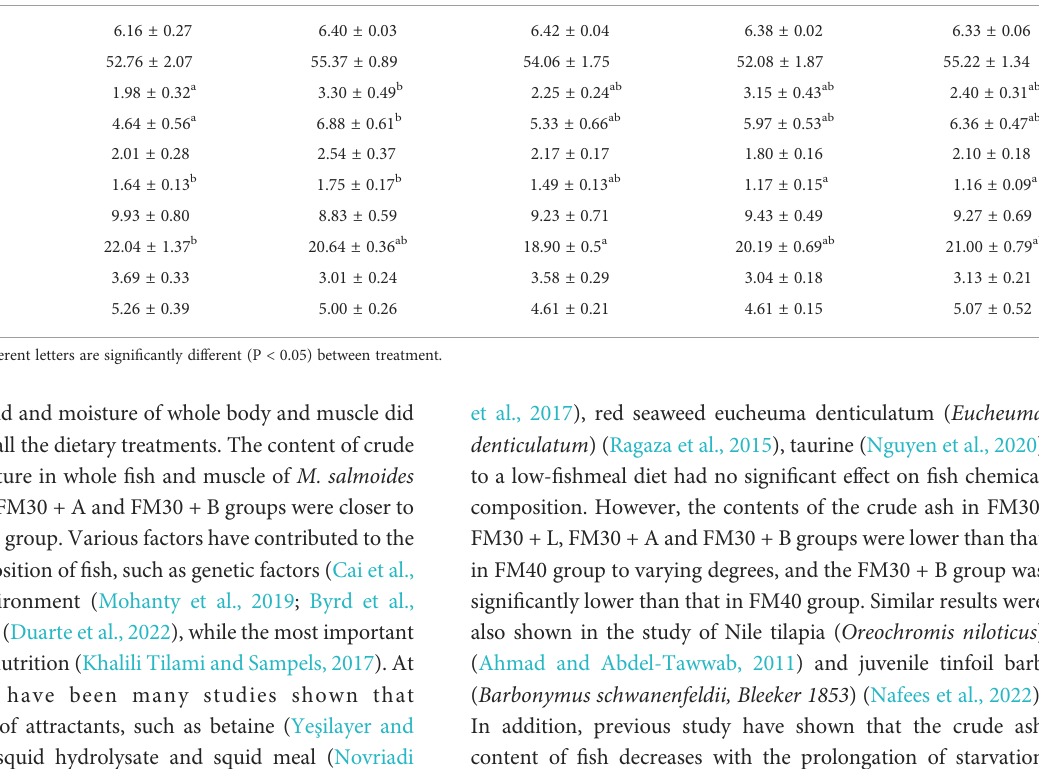
TABLE 6 Effects of limonene, allicin and betaine on meat quality of M. salmoides for 9 weeks.